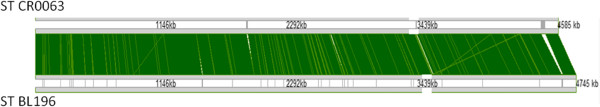
Comparison of Salmonella Typhi strains ST CR0063 and ST BL196. Comparison of whole genome sequences of S. Typhi strains using MG-CAT – one strain was isolated from a carrier individual (ST CR0063) and another from an infected individual (ST BL196) during a prolonged outbreak of Typhoid fever in Kelantan
[13].